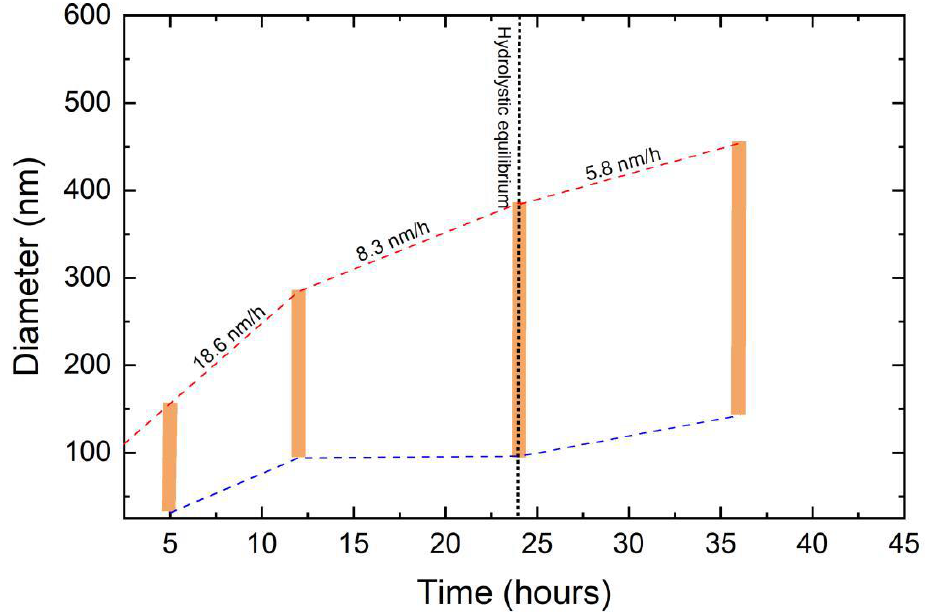
Figure 6. Grain size diagram of OsO 2 nanospheres from various timepoints synthesized at 300 °C and 100 MPa using 0.002 mol/L initial solution.